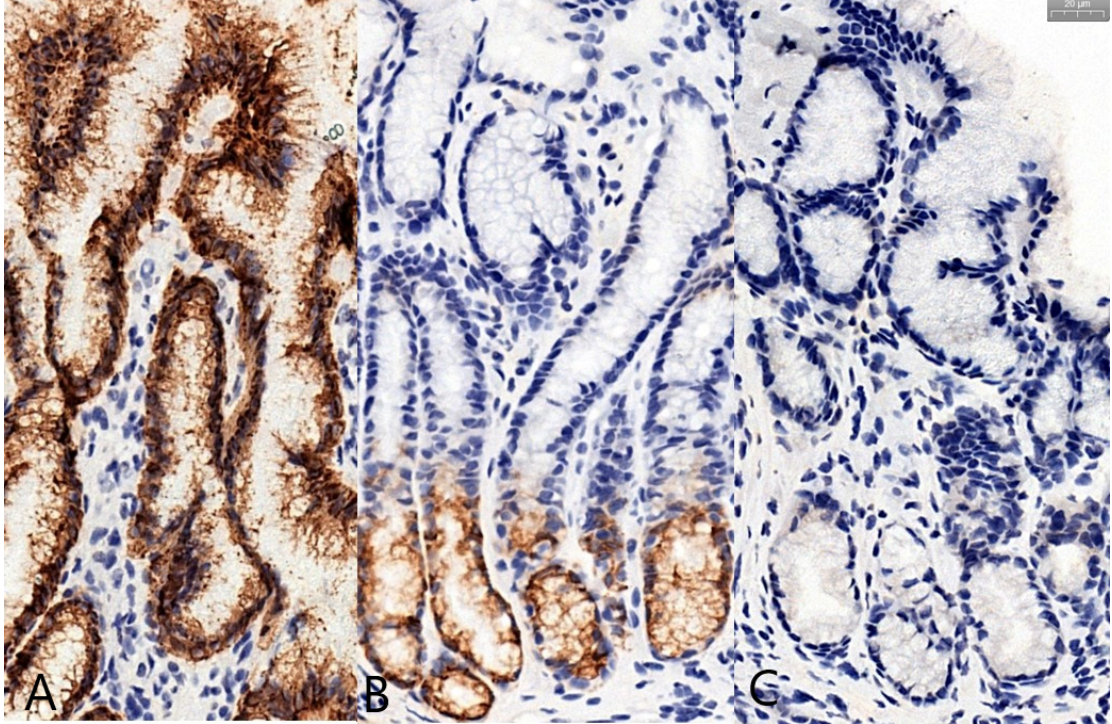
Figure3. Examplesofmucinexpression(40 × objectiveX):MUC5ACscoredasIRS = 12( A ),MUC6scored as IRS = 8 ( B ) and MUC2 scored as IRS = 0 ( C